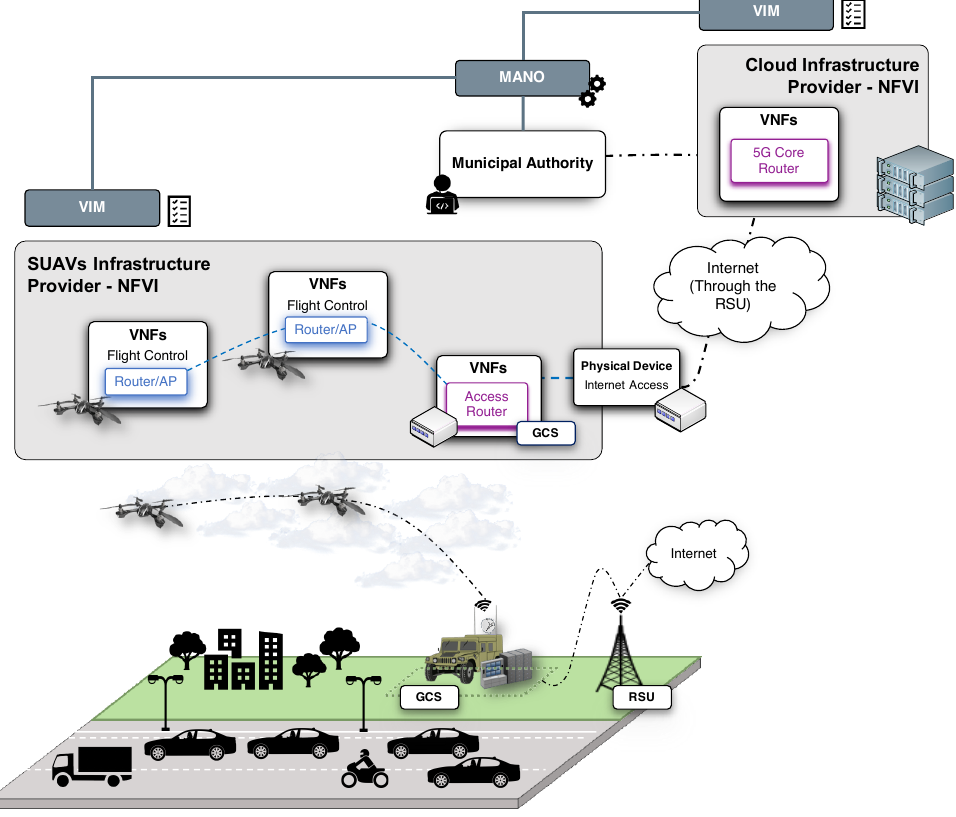
Figure 3. Overview of the initial service provided by the SUAVs